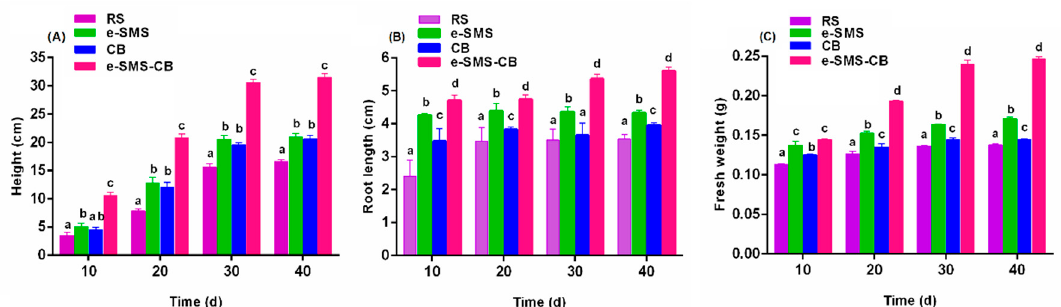
Figure 5. E ff ects of chlorimuron-ethyl on wheat with increasing incubation time. ( A ) plant height, ( B ) plant length and ( C ) fresh weight. The bars represent the SDs of assays performed in triplicate. RS: real soil as control group; e-SMS: real soil + P. eryngiu -SMS; CB: real soil + co-culture bacteria; e-SMS-CB: real soil + P. eryngiu -SMS-CB. Bars with di ff erent letters are significantly di ff erent at the p < 0.05 level.